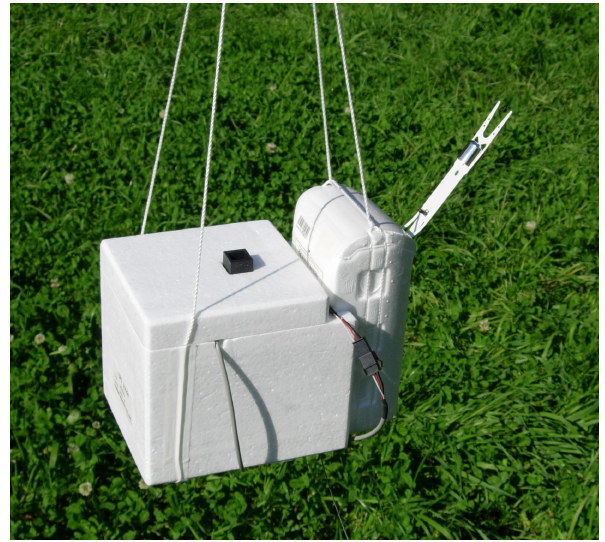
Figure 2. Photograph of the latest version CPS within its flight package (with a black inlet duct on top) connected to the Meisei RS-11G radiosonde (with the temperature and RH sensor boom). The three 3-V lithium batteries and the interface board are placed within the CPS flight